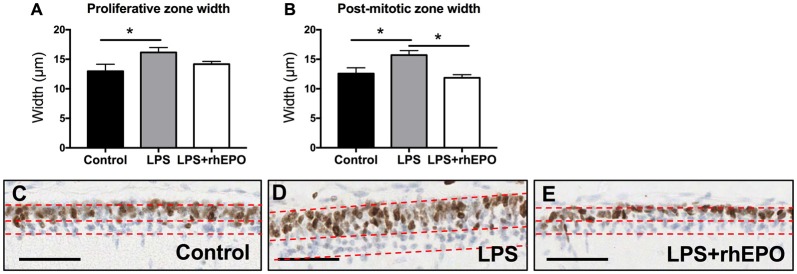
Proliferation in the external granule layer (EGL). Mean (±SEM) width of the (A) proliferative zone and (B) the post-mitotic zone in saline-treated (Controls; black bars), LPS-treated (gray bars) and LPS + rhEPO-treated (white bars) fetal sheep. *p < 0.05. Ki67 staining (brown nuclei) in the EGL of (C) saline-treated (Control), (D) LPS-treated and (E) LPS + rhEPO-treated fetal sheep. All images counterstained with hemeatoxylin (blue). Red dotted lines show the borders of the proliferative zone (brown stained cells, upper portion of the EGL) and the post-mitotic zone (blue stained cells, lower portion of the EGL). Scale bar = 50 μm.